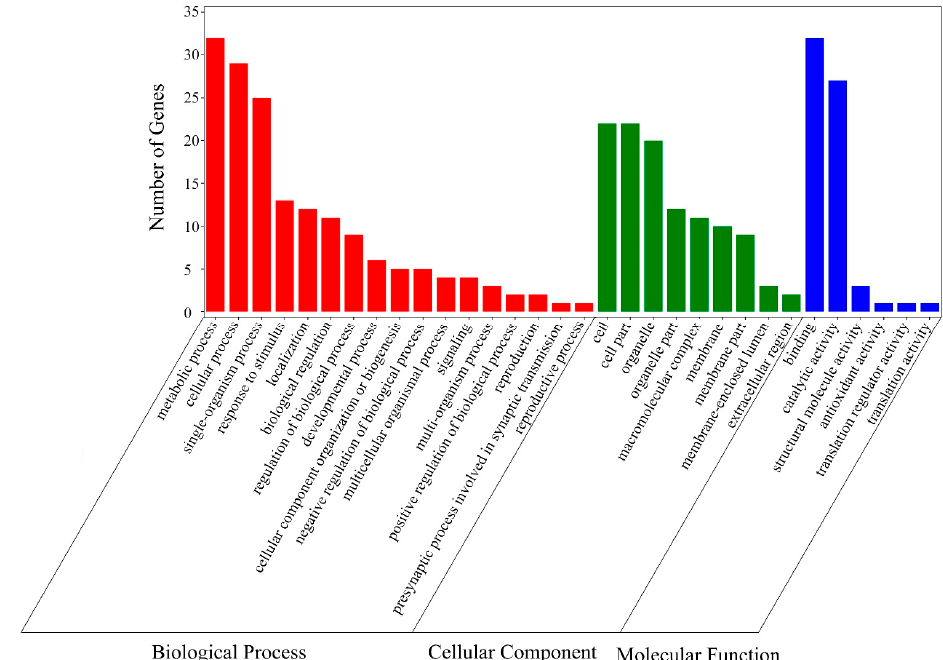
Figure 5. A GO analysis of the 112 genes.